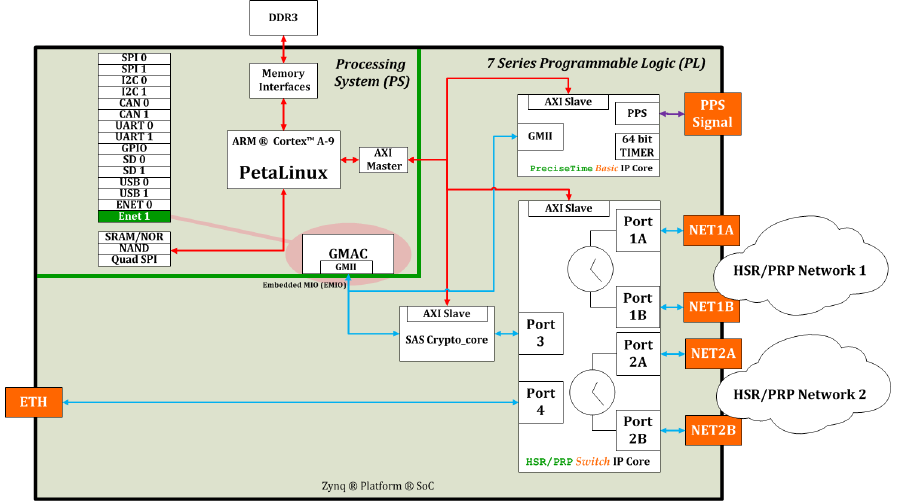
Figure 1. New generation System-on-Chip (SoC) based intelligent electronic devices (IEDs). Include the IEEE 1588 support, HSR/PRP and Crypto-core